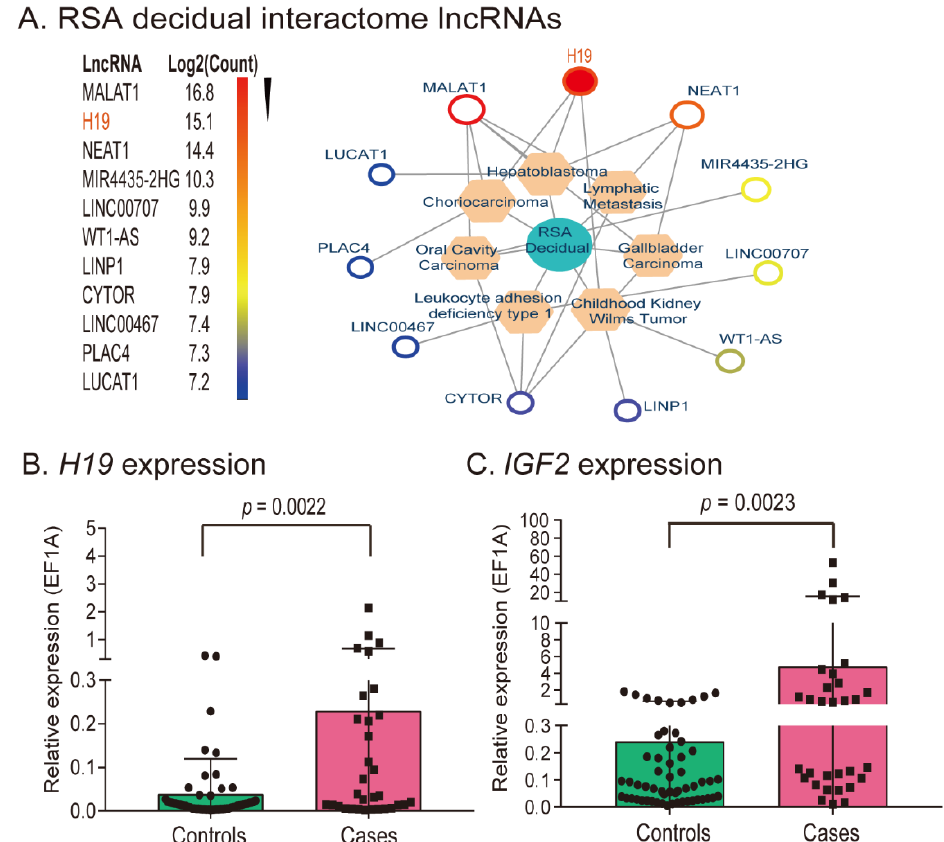
Figure 1. Identification of RSA-associated lncRNAs by integrating RNA-seq data from RSA patients and senescent decidualized human endometrial stromal cells. ( A ) Identification of RSA-associated lncRNAs. Differentially expressed lncRNAs were analyzed using the RNA transcriptome sequencing dataset GSE178535. The top 11 differentially expressed lncRNAs are ranked based on the RNA expression-fold from high (red) to low (blue) between the RSA patients and the controls. ( B ) Upregulated H19 in decidual tissues from RSA cases. Thirty-two decidual tissues with unexplained RSA were collected as the case group. As the control, 57 decidual tissues samples were obtained from healthy adult women who were diagnosed with early pregnancy and were undergoing legal elective termination. Gene expression was measured by qPCR and standardized over the value of the EEF1A1 control. All data shown are mean ± SD. Error bars represent the SD of the average of three independent PCR reactions. p = 0.0022 as compared with the CTL control. ( C ) Reciprocal upregulation of IGF2 in decidual tissues of RSA cases. p = 0.0023 as compared with the CTL control.